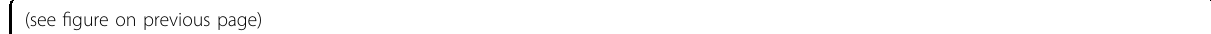
Fig. 4 FIP1 binds to NLRP3 mRNA via C-terminal arginine-rich domain to induce 3 ′ UTR shortening of NLRP3 and is upregulated in injured kidneys and CKD specimens. A qRT-PCR was performed to determine the normalized fold changes of distal PAS usage of NLRP3 in HK2 cells transfected with each indicated APA trans-factor. B 3 ′ RACE was performed to determine the expression of mRNA isoforms of NLRP3 in HK2 cells transfected with CSTF2, CFIm59, or FIP1 respectively. C Western blots were performed and quantitatively analyzed to detect protein levels of NLRP3 in HK2 and HKC cells transfected with Flag-FIP1 or empty vector. D Immuno fl uorescence staining was performed to detect protein levels of NLRP3 in HK2 cells transfected with Flag-FIP1. E RNA immonuprecipitation (RIP) assay was performed to determine the region of NLRP3 3'UTR which FIP1binds to. And qRT-PCR was performed to quantify the relative enrichment of NLRP3 3 ′ UTR regions associated with FIP1 relative to the input. IgG was used as a control. F Schematic diagram showing the truncated regions of FIP1 used for RIP assay. G RIP assay was performed to map the binding region of FIP1 to NLRP3 3 ′ UTR. And qRT-PCR was performed to quantify the relative enrichment of NLRP3 mRNA levels associated with each truncated FIP1 relative to the input. IgG was used as a control. H Western blot was performed and quantitatively analyzed to determine the protein levels of FIP1 in UUO kidneys ( n = 5) compared to normal kidneys ( n = 5). I Correlation of normalized protein levels of FIP1 with normalized dPAS usage value of NLRP3. J Correlation of normalized protein levels of FIP1 with normalized protein levels of NLRP3. K Immuno fl uorescence staining was performed to detect protein levels of FIP1 in UUO or IRI kidneys compared to normal kidneys. L Representative images of IHC staining for FIP1 in FIP1 high-expressed and FIP1 low-expressed CKD specimens. M The scatter plot demonstrating the eGFR of patients with high FIP1 expression ( n = 17) and those with low FIP1 expression ( n = 10). N The correlation analysis between FIP1 expression and proteinuria in CKD patients. ** P < 0.01; *** P < 0.001; All data represent the mean ± SEM obtained from three independent experiments. Student ’ s t